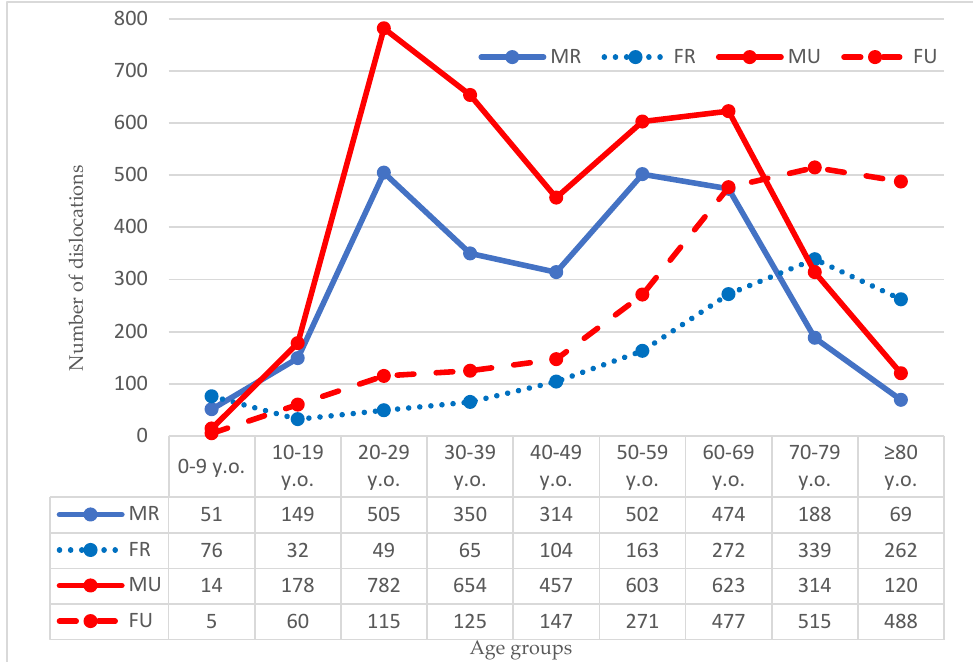
Figure 2. Number of dislocations by age and sex. Legend: MR, male rural population; FR female rural population; MU, male urban population; FU, female urban population.